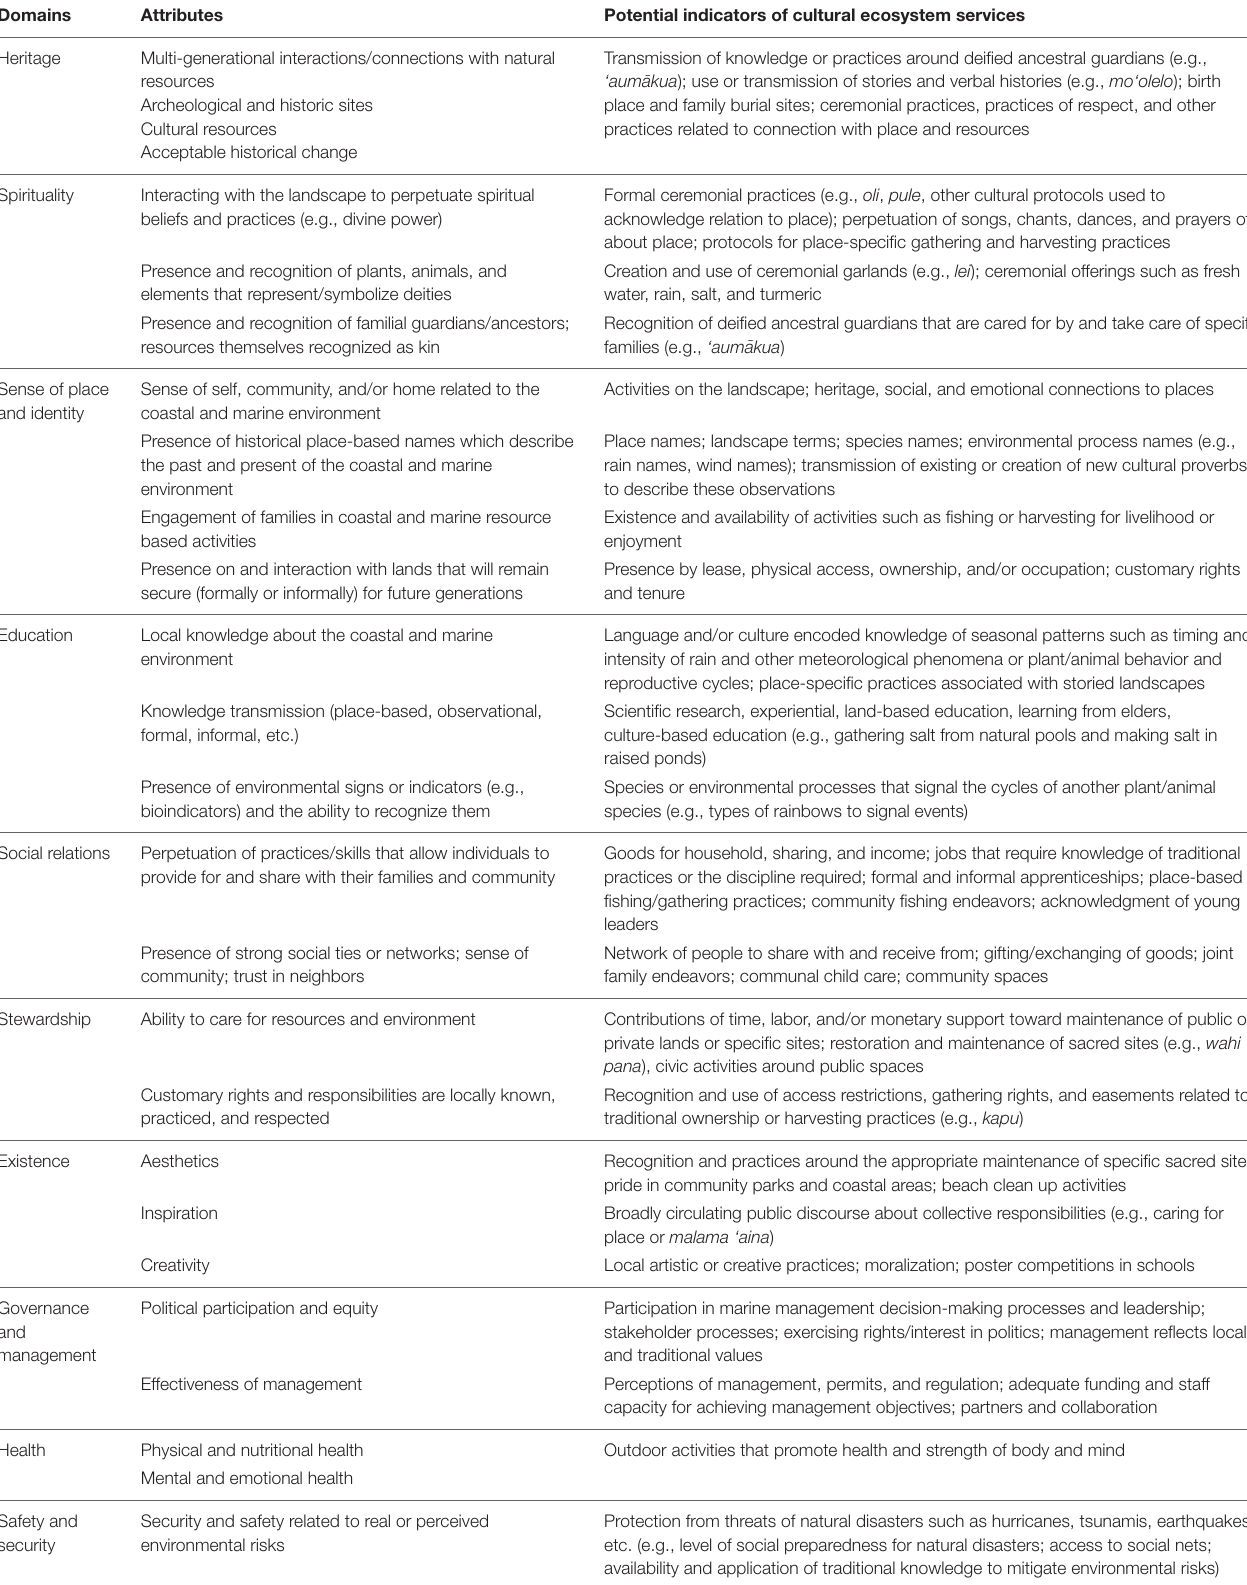
TABLE 2 | Human well-being domains, example attributes, and potential indicators for cultural ecosystem services in West Hawai‘i. Domains Attributes Potential indicators of cultural ecosystem services Heritage Multi-generational interactions/connections with natural